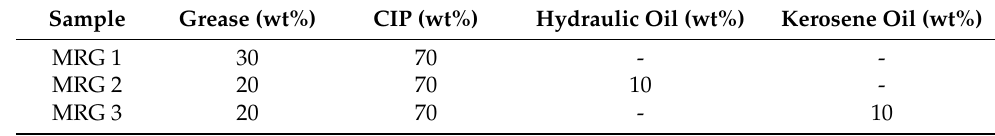
Table 1. The composition of the sample of MRG with a different types of oil dilution.